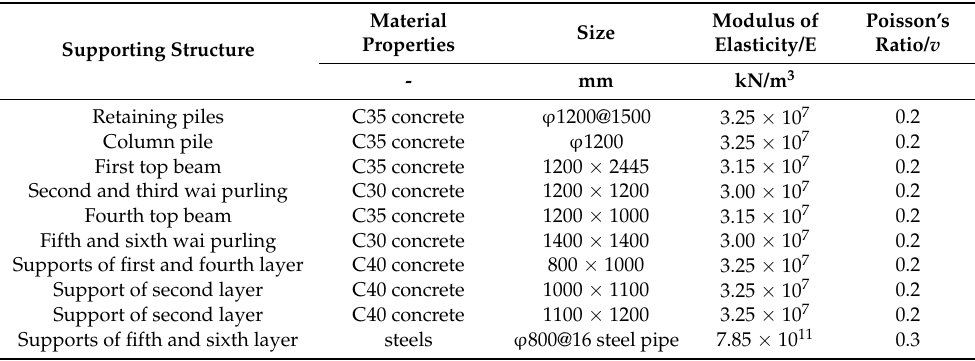
Table 2. Material parameters of supporting